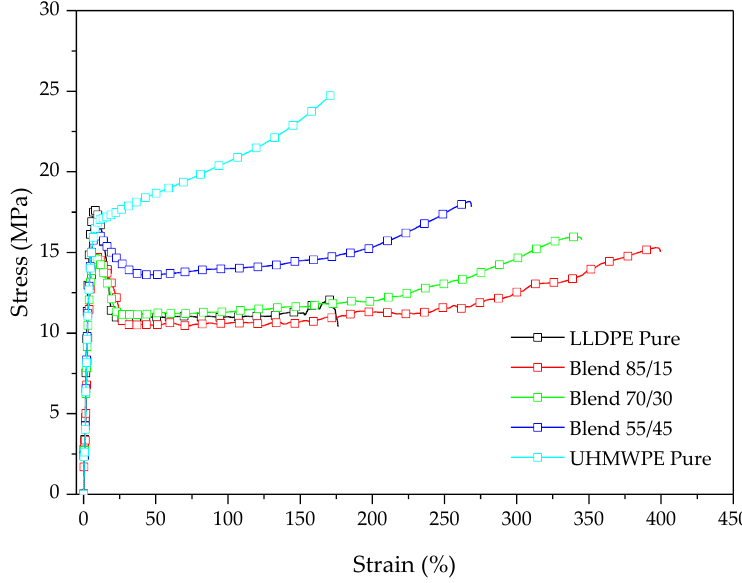
Figure 4. Schematic diagram of the two stages in press molding, adapted from [32].